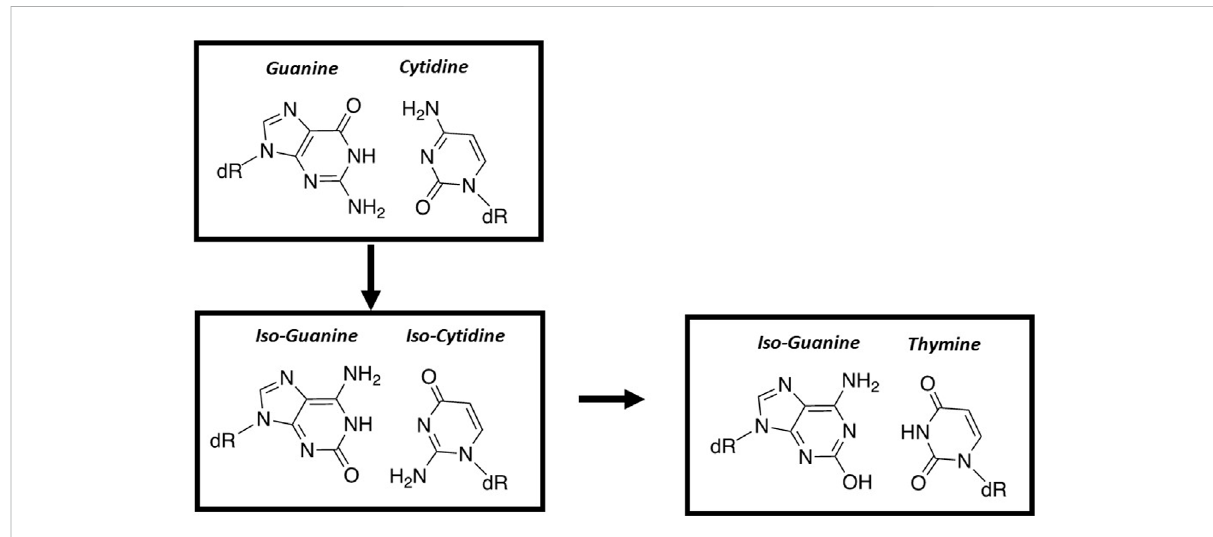
FIGURE 9 Structural comparison of nucleobase-modi fi ed base pairs composed of iso-guanine and iso-cytosine with the natural G:C base pair.